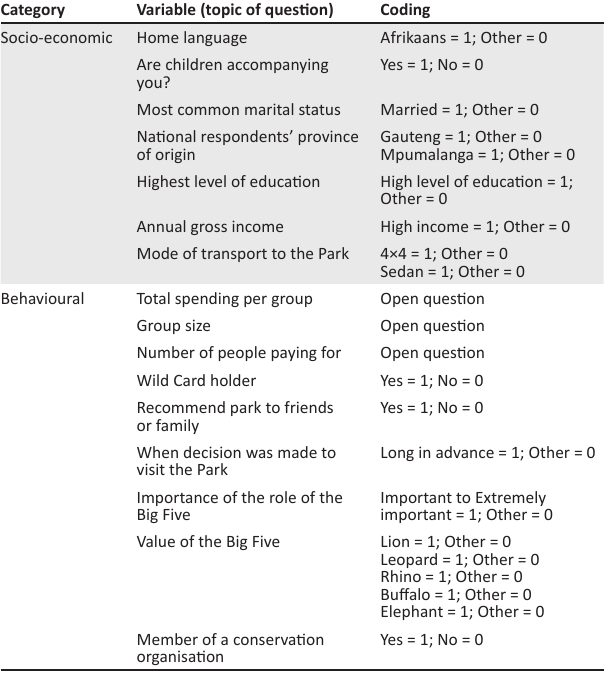
TABLE 3: Relationship between variables and respondents’ length of stay.